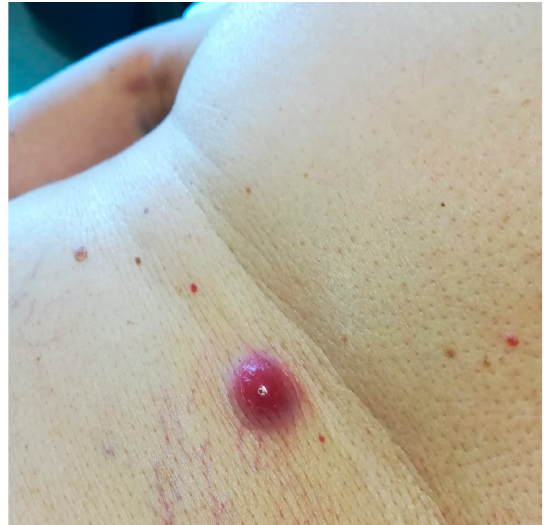
Figure 9. Cutaneous localization of MM: in vivo image of cutaneous purpuric nodule (original image from Prof. S.A).